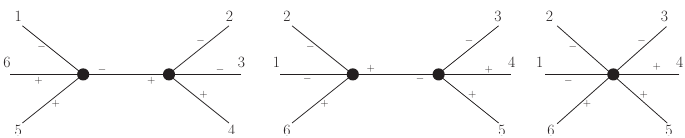
Figure 4: Contributions to the 6-point ( − − − + ++) NMHV amplitude. (Source of the figure: Ref. [ 8 ] .)